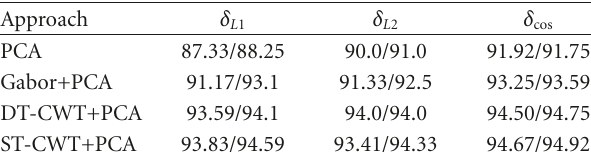
Table 6: Face recognition performance for di ff erent approaches using 100/200 features and ORL database with three di ff erent similarity